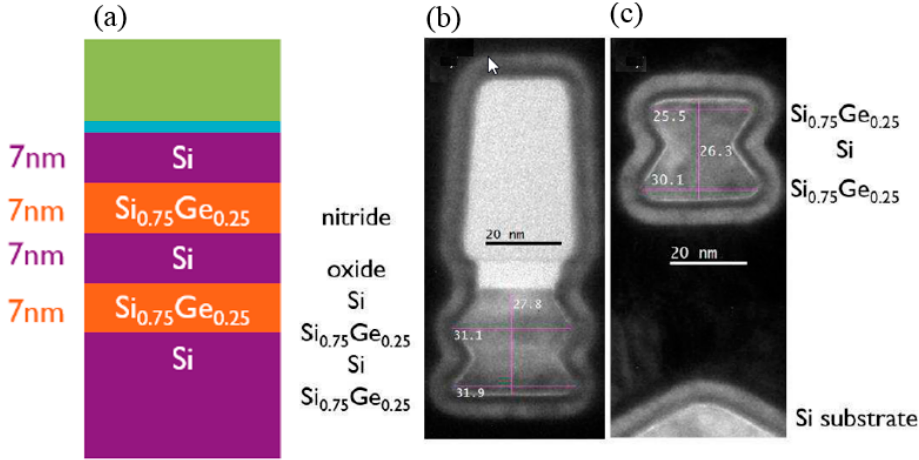
Figure 18. ( a ) Schematic picture of a stack of Si 0.75 Ge 0.25 /Si NW used for selective etch and TEM across a section of 30-nm wide Si-Si 0.75 Ge 0.25 NWs after Si selectively etched ( b ) in TMAH 5% and ( c ) without the oxide-nitride HM [127].